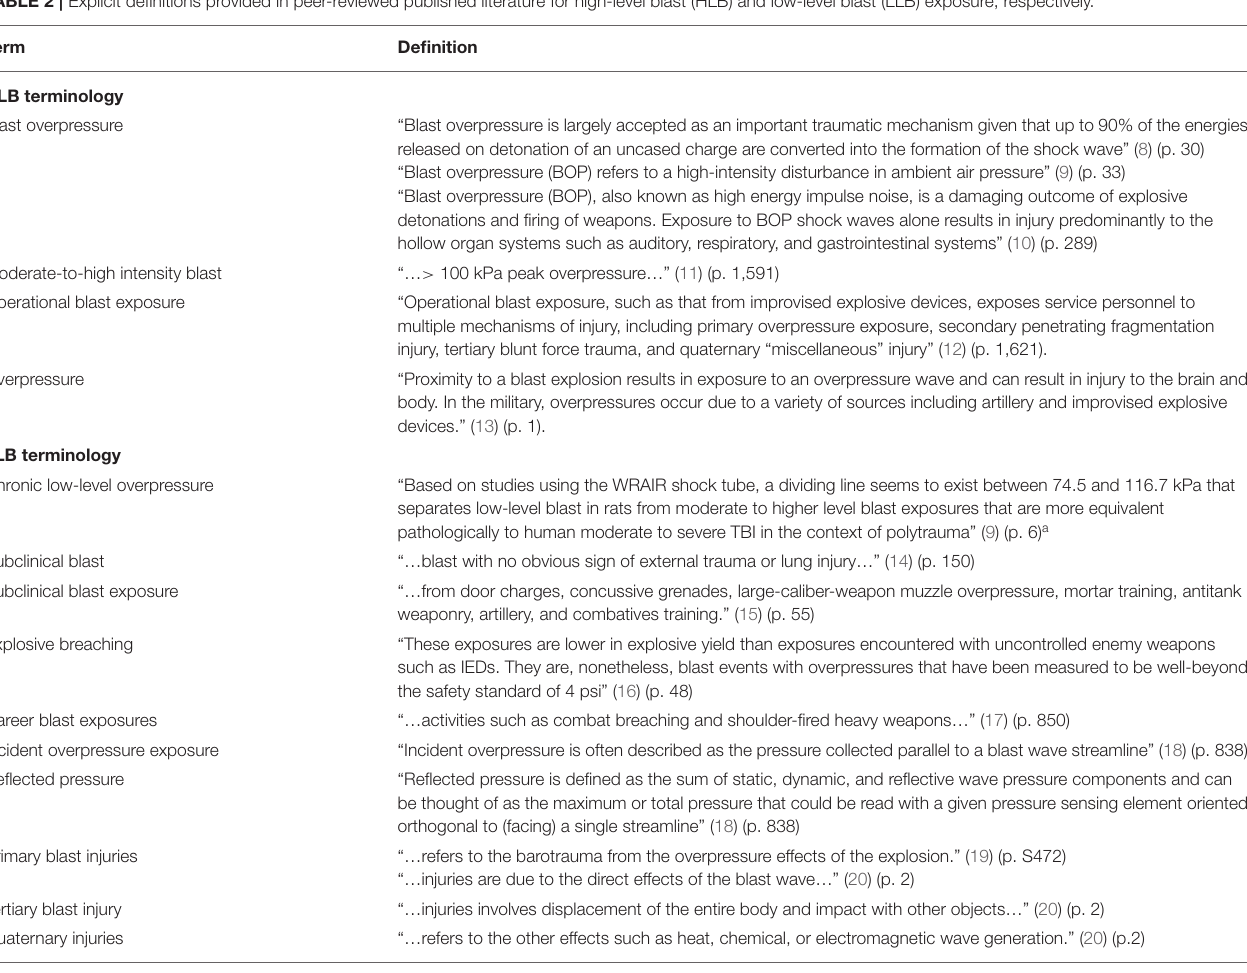
TABLE 2 | Explicit definitions provided in peer-reviewed published literature for high-level blast (HLB) and low-level blast (LLB) exposure,